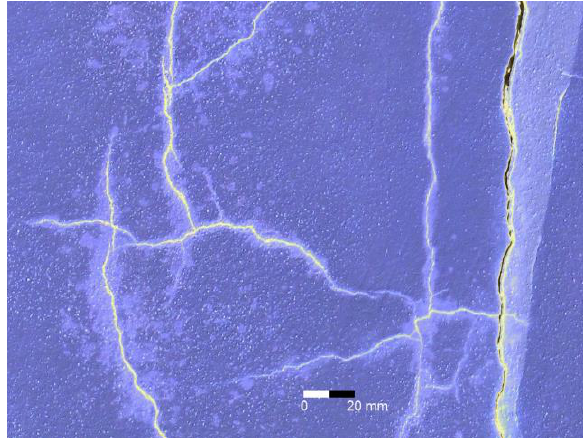
Figure 6. Crack inspection in millimeter range (image